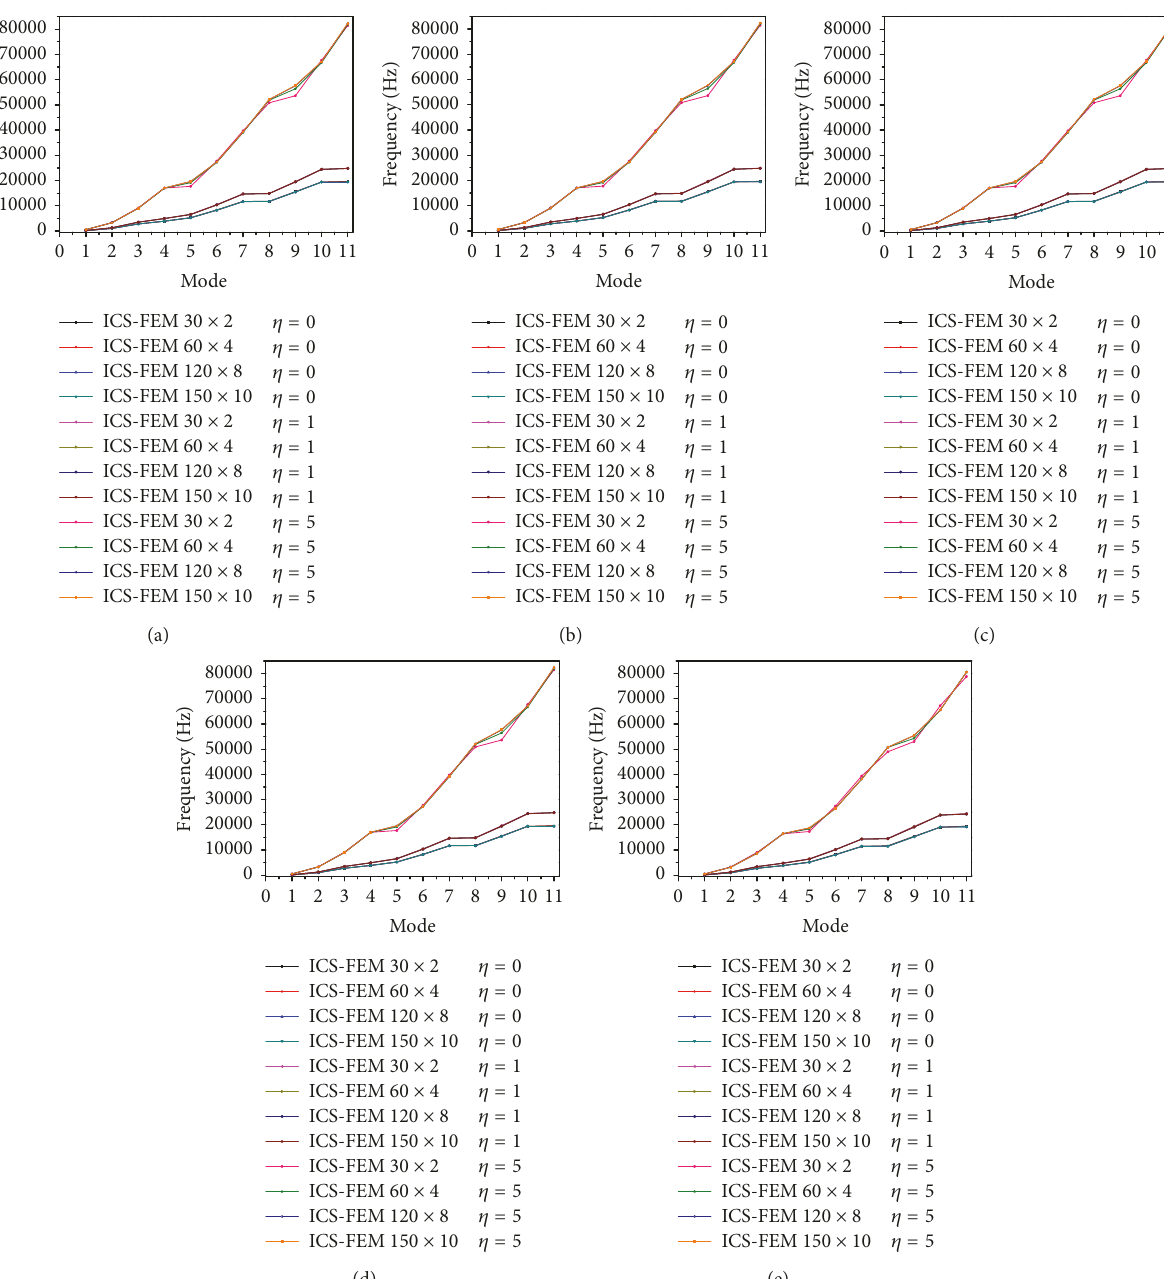
Figure 5: Structural frequencies (a) 𝑓 uu ; (b) 𝑓 eq ; (c) 𝑓 eq